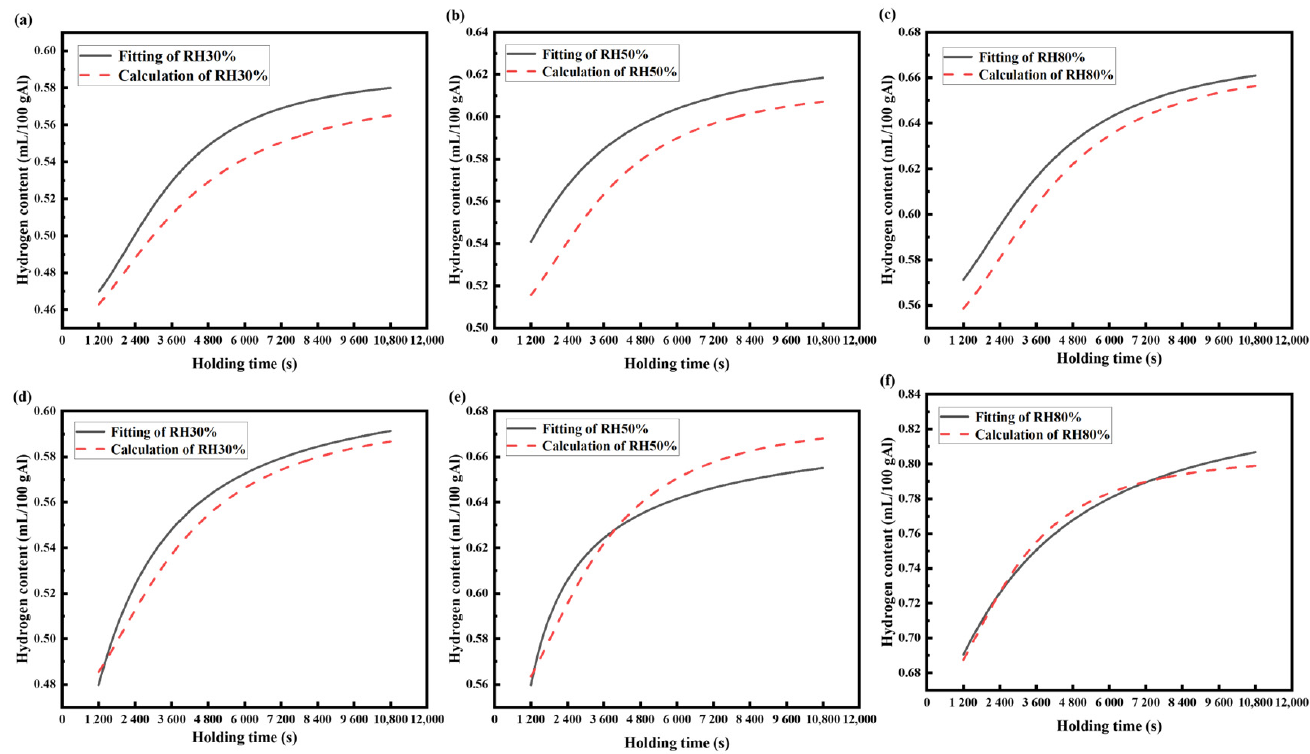
Figure 9. The comparison between the calculated results and the experimental data: ( a – c ) 973 K, ( d – f ) 1023 K. Table 4. Measurement and calculation of the parameters for the solution of equations. Lots Parameters